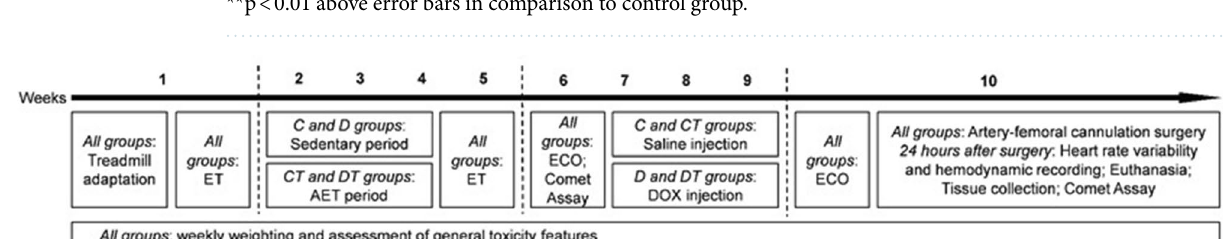
Figure 4. Preventive exercise training attenuates hemodynamic and sympathovagal imbalance induced by doxorubicin. ( A ) SBP: systolic blood pressure (mmHg); ( B ) DBP: diastolic blood pressure (mmHg); ( C ) Heart rate (bpm); ( D ) HRV: heart rate variability (ms 2 ); ( E ) LF/HF ratio: low frequency/high frequency ratio as sympathovagal balance; ( F ) LF: low frequency representative of sympathetic component (Hz); ( G ) HF: high frequency representative of parasympathetic component (Hz). C: control (for hemodynamic parameters: n = 8; for sympathovagal parameters: n = 5); D: doxorubicin-treated (n = 8); CT: control-trained (for hemodynamic parameters: n = 10; for sympathovagal parameters: n = 7); DT: doxorubicin-trained (for hemodynamic parameters: n = 7; for sympathovagal parameters: n = 5). One-way ANOVA and Tukey’s post-hoc. *p < 0.05, **p < 0.01 above error bars in comparison to control group.